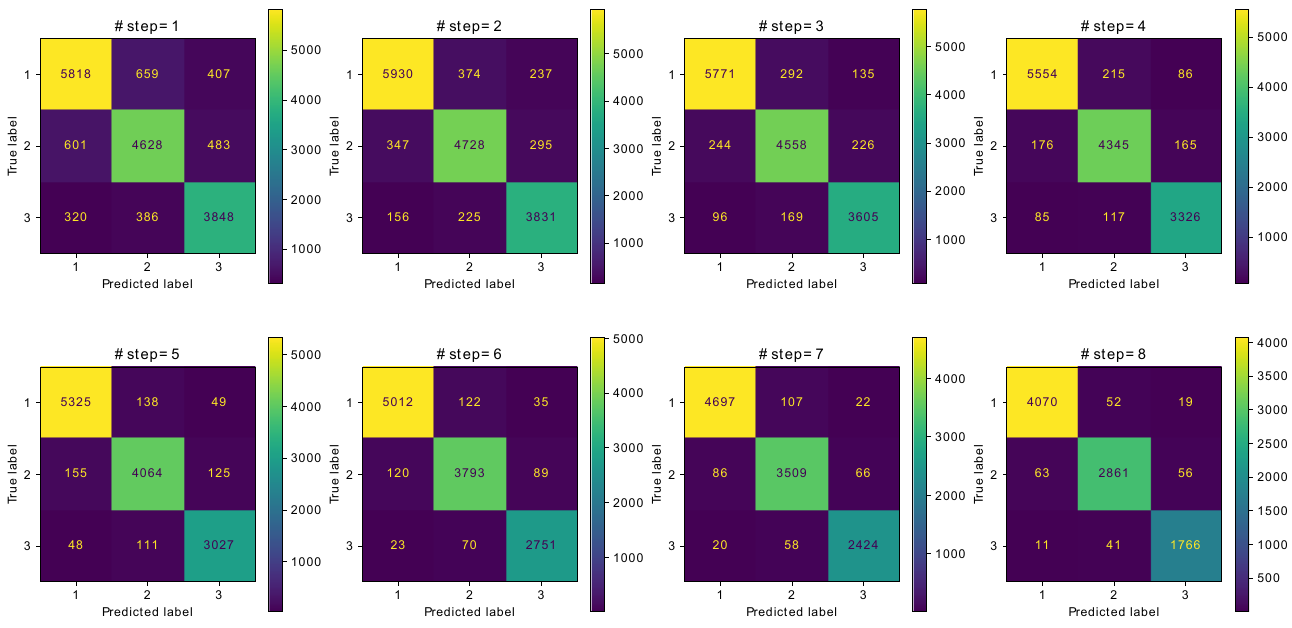
Figure 5. Confusion matrices of ambulatory recognition with respect to the number of